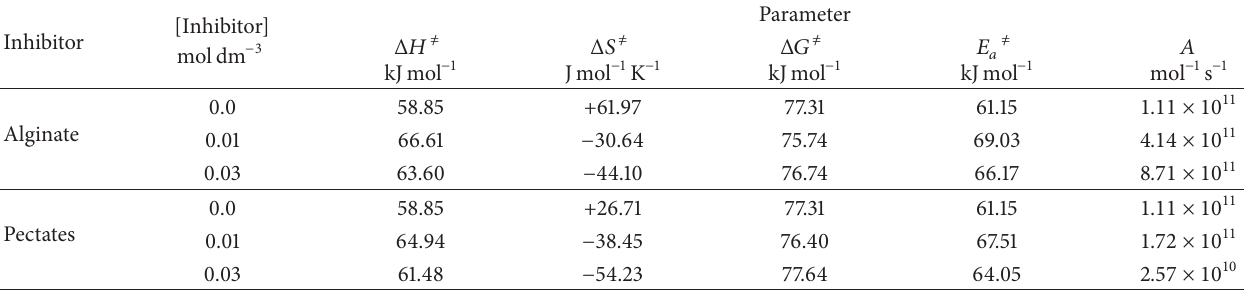
Table 3: Activation parameters for corrosion of Al in alkaline media in absence and presence of some added inhibitors. [OH − ] = 4.0 and I = 4.0 moldm − 3 .